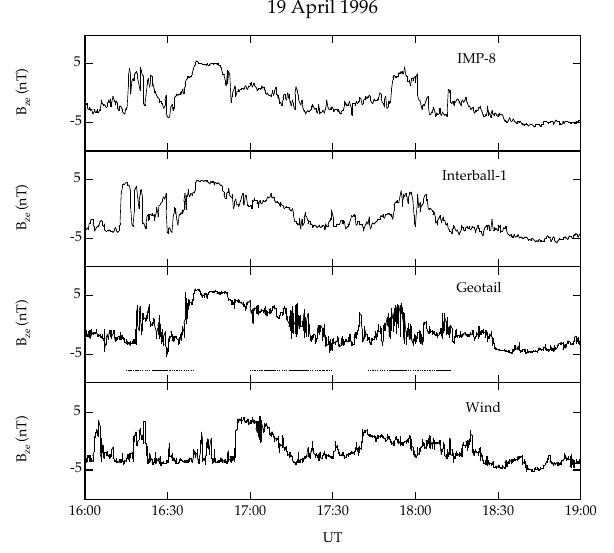
Figure 9. IMP-8, Interball-1, Geotail, and Wind observations of IMF Fig. 9. IMP-8, Interball-1, Geotail, and Wind observations of IMF Bz in GSE coordinates from 1600 to 1900 UT on April 19, 1996. B z in GSE coordinates from 16:00–19:00 UT on 19 April 1996.